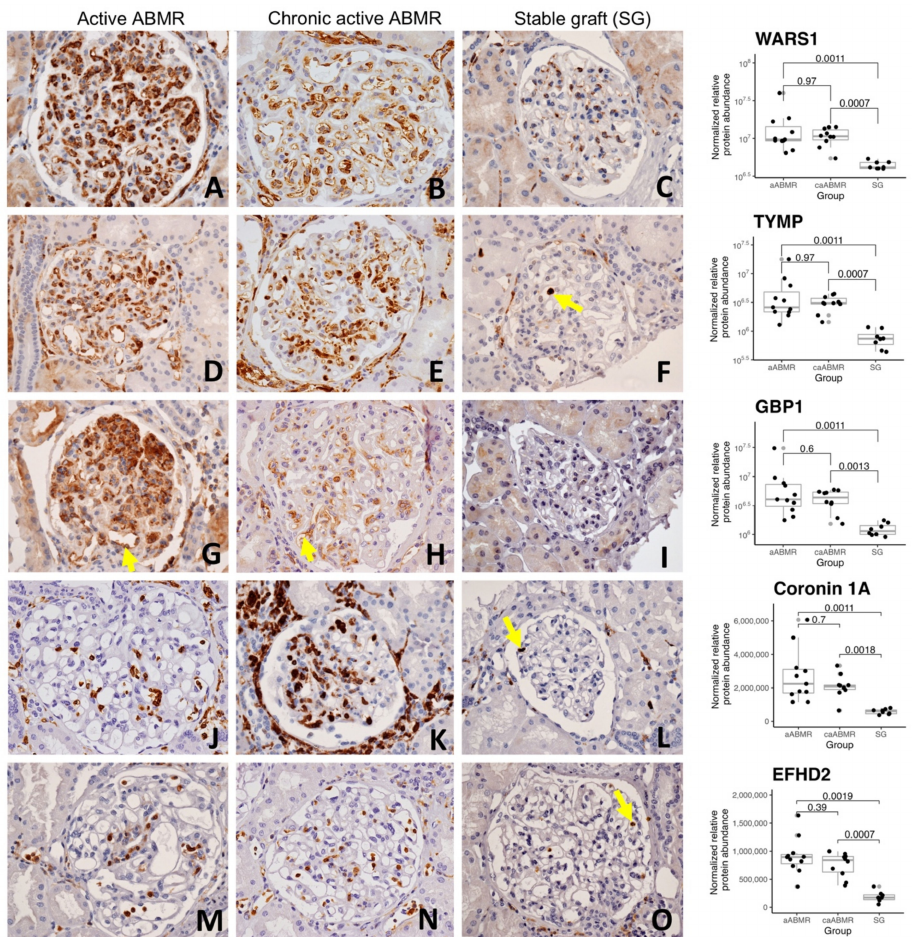
Figure 3. Highlighting glomerulitis with illustrative cases of glomerular immunostains for WARS1, TYMP, GBP1, CORO1A and EFHD2 in active (left), chronic active antibody-mediated rejection (middle) and stable graft control cases (right), original magnification × 400 (( A )–( O ), respectively). Corresponding proteomic results depending on groups are displayed on the right-hand side, with adjusted p -values for each comparison (Mann-Whitney U tests and Benjamini-Hochberg correction). ( A , B ) show a diffuse cytoplasmic overexpression of WARS1 on endothelial cells in a glomerulus of an active and chronic active ABMR cases, with a strong and moderate positivity, respectively, compared to the constitutive weak and segmental endothelial staining observed in the stable graft control ( C ). ( D , E ) show a diffuse and moderate to strong overexpression of TYMP in endothelial cells, but also a strong staining in endocapillary inflammatory cells ( E ). ( F ) Rare inflammatory cells are strongly stained for TYMP (arrow), without endothelial staining in the glomerulus. ( G ) shows a strong staining for GBP1 in endothelial (arrow) and inflammatory cells in the glomeruli (focus of glomerulitis at the top). ( H ) displays a segmental and weak to moderate staining in some endothelial (arrow) and inflammatory cells. ( I ) No specific staining for GBP1 in a stable graft case. ( J , K ) show a strong, nuclear and cytoplasmic staining for CORO1A in noticeably all inflammatory cells, wherever they are. Many positive cells are visible in the glomerulus of both ABMR cases, with a segmental and global lesion of glomerulitis, respectively. ( L ) shows the same expression pattern of CORO1A, but limited to a few inflammatory cells in the peritubular capillaries or the interstitium, and just one cell in the glomerulus (arrow). ( M , N ) show a moderate to strong, nuclear and cytoplasmic staining for EFHD2 antibody in some inflammatory cells in the glomeruli of both ABMR cases. Of note, stained inflammatory cells are also seen in the nearby peritubular capillaries. ( O ) shows a similar pattern of expression of EFHD2, but with globally much fewer positive cells, limited in the glomerulus